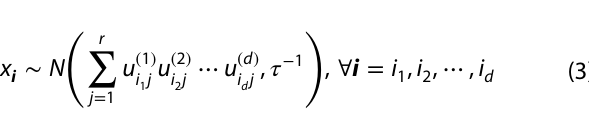
Fig. 3 Schematic diagram of CP decomposition of the third-order tensor